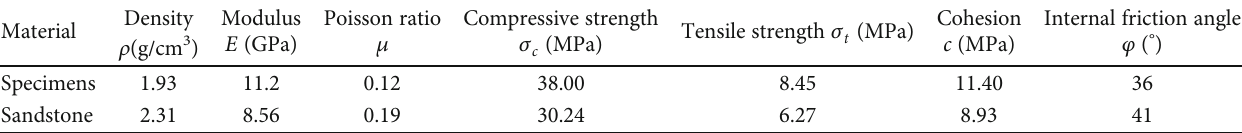
Figure 3: Experimental rock specimens [46]. Table 1: Physical and mechanical parameters of specimens and sandstone